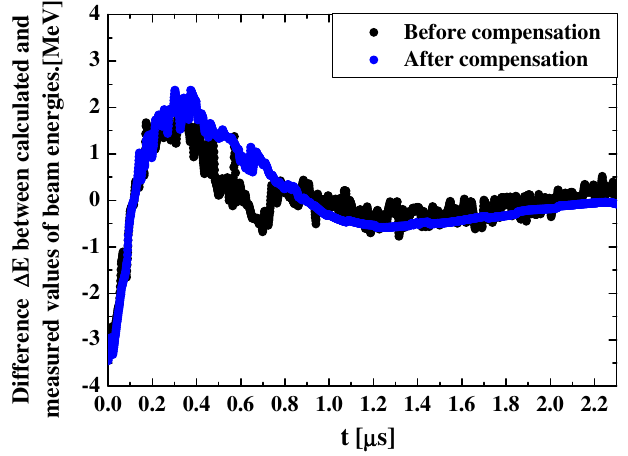
FIG. 18. (Color) Difference between calculated and measured beam energies before and after